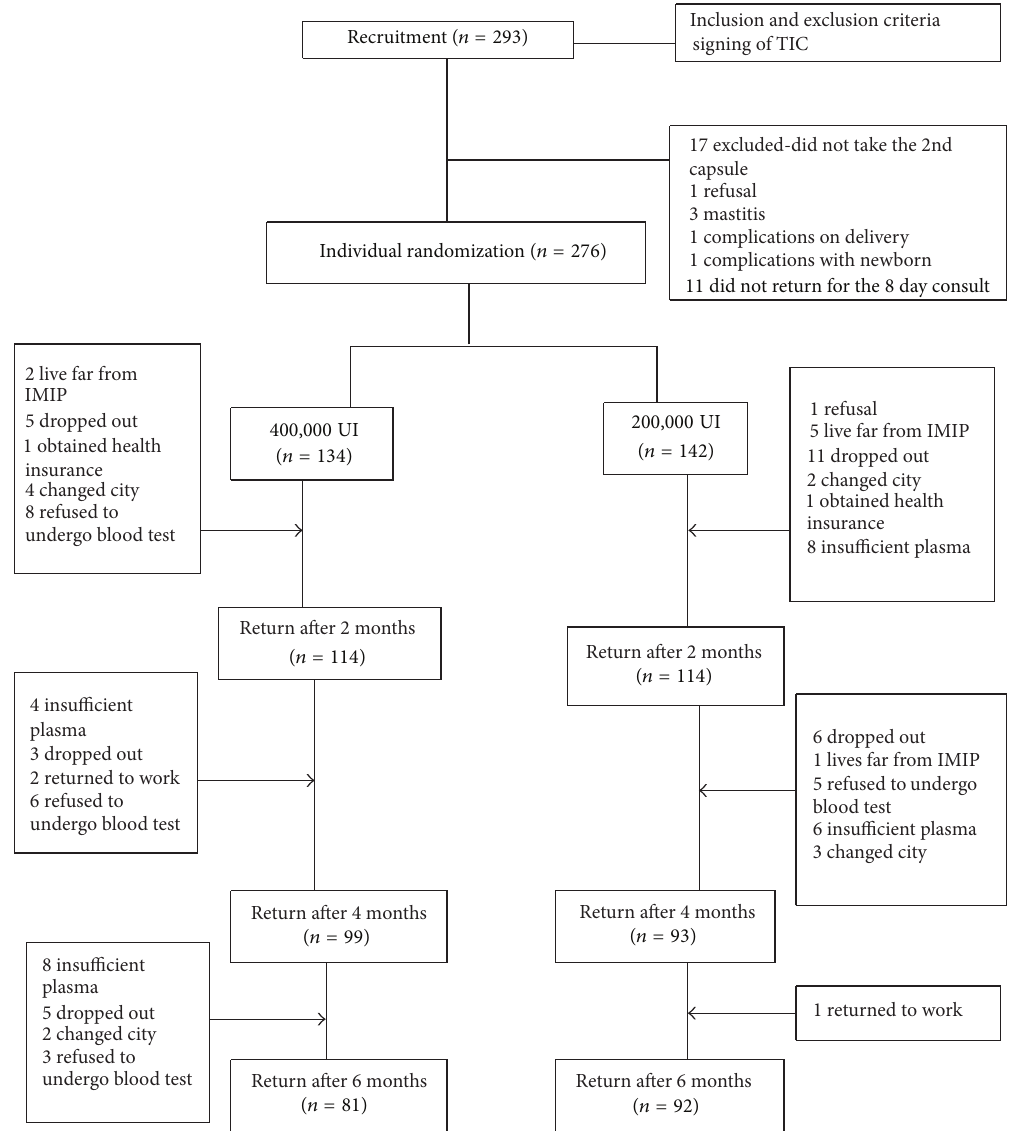
Figure 1: Flowchart of